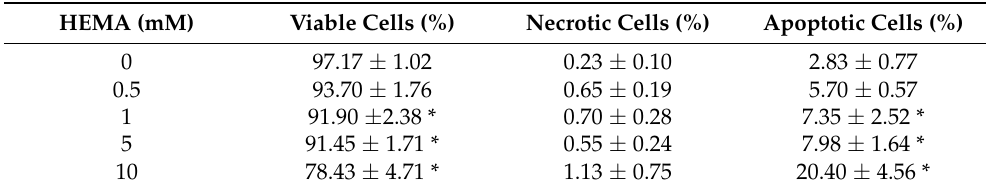
Table 1. The parameters of cell responses in RAW264.7 macrophages exposed to the different concentrations of HEMA for 24 h in Annexin V-FITC apoptosis-detection kit.